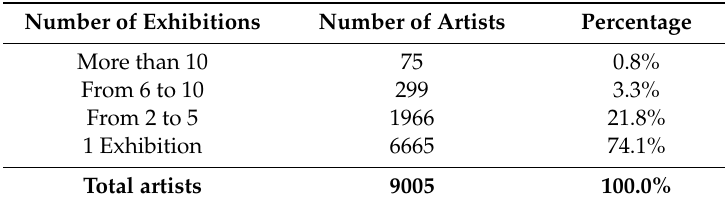
Table 8. Artists and number of